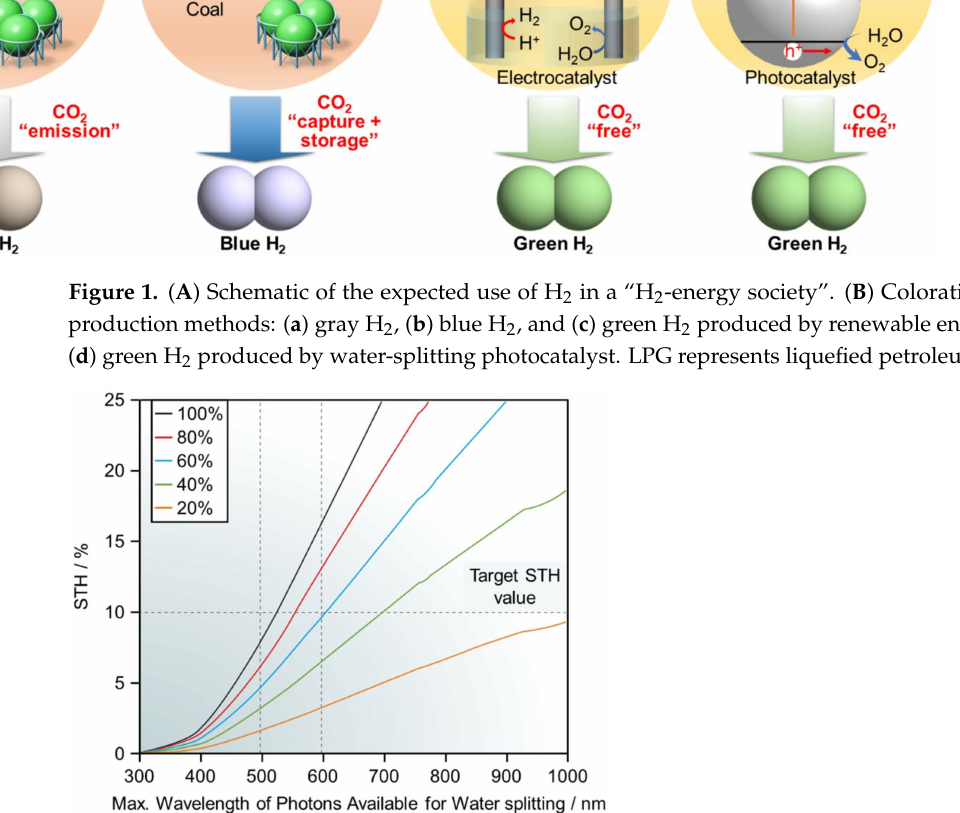
Figure 2. Different apparent quantum yields (AQYs) covering the typical range of 20–100%. Dashed lines represent STH efficiencies at different AQYs with the maximum operable wavelength of 500 or 600 nm and the target STH value of 10%. Associated calculations assumed AM1.5G solar irradiance. Reproduced with permission from reference [44]. Copyright 2017 Springer Nature